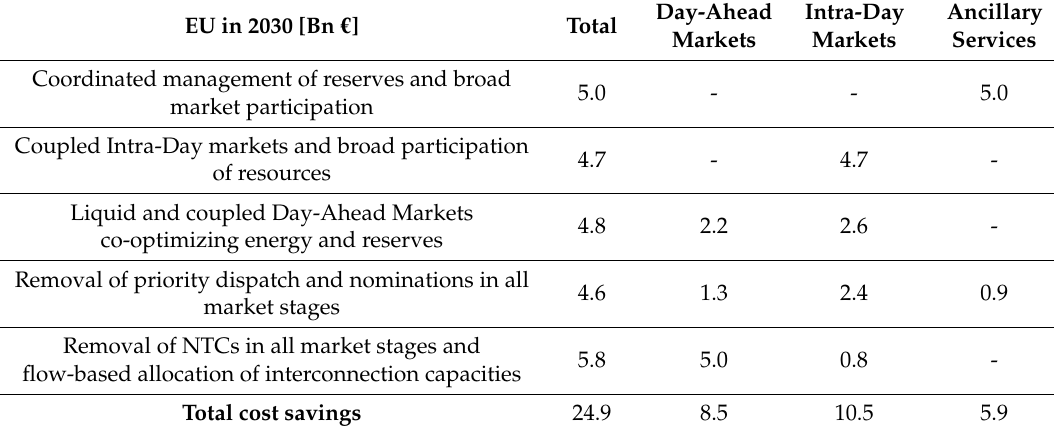
Table 5. Decomposition of cost savings by type of reform measure.